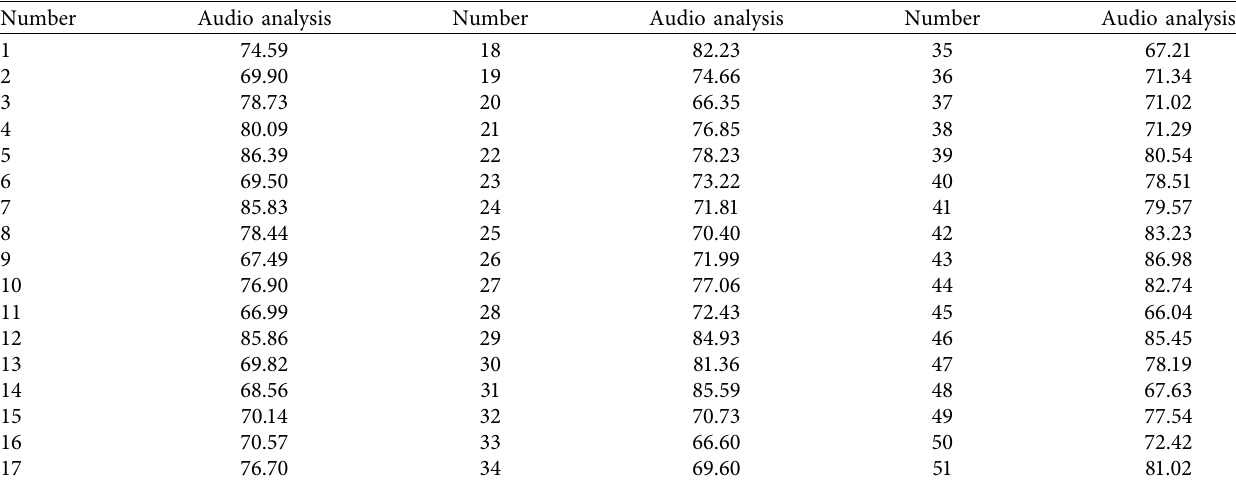
Table 1: Statistical table of music audio analysis effect of the music audio analysis model based on spectrum analysis technology. Number Audio analysis